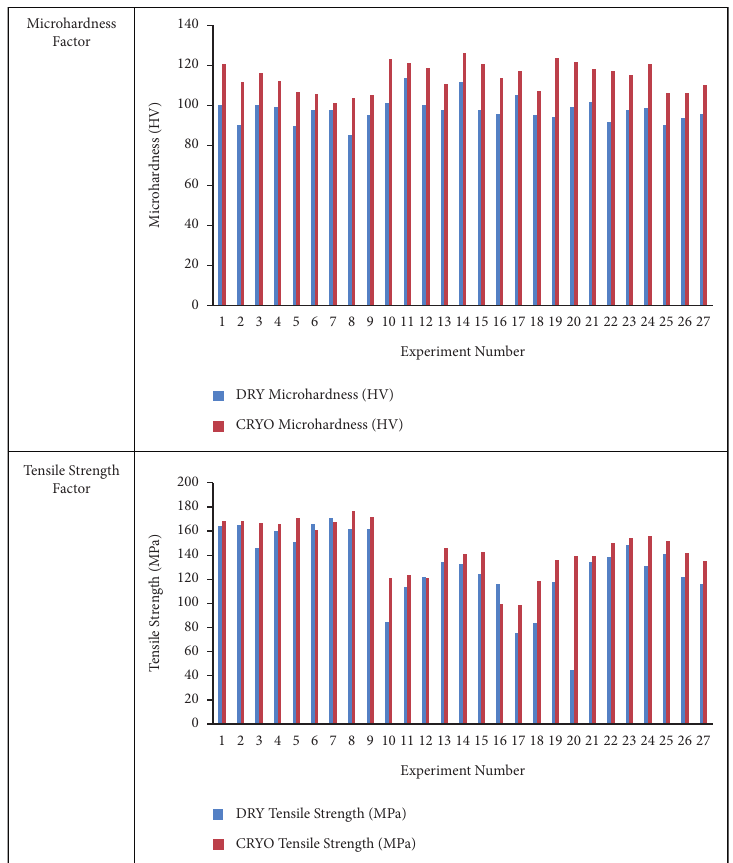
Figure 12: Comparison study of dry and cryogenic friction stir welding of AA 7075 aluminium alloys.